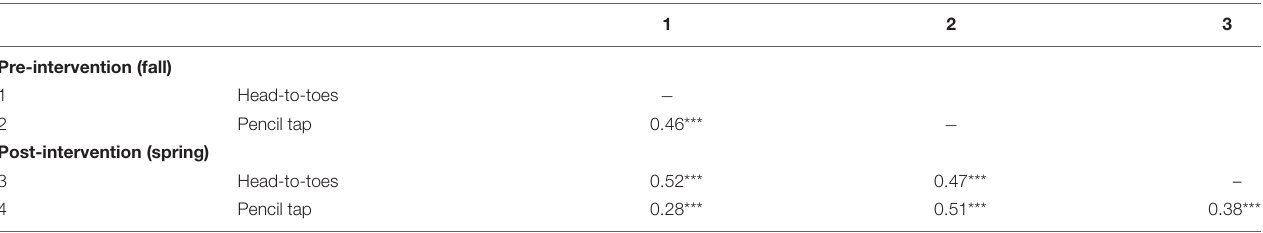
TABLE 2 | Correlations between and among children’s pre-intervention and post intervention executive function outcomes.